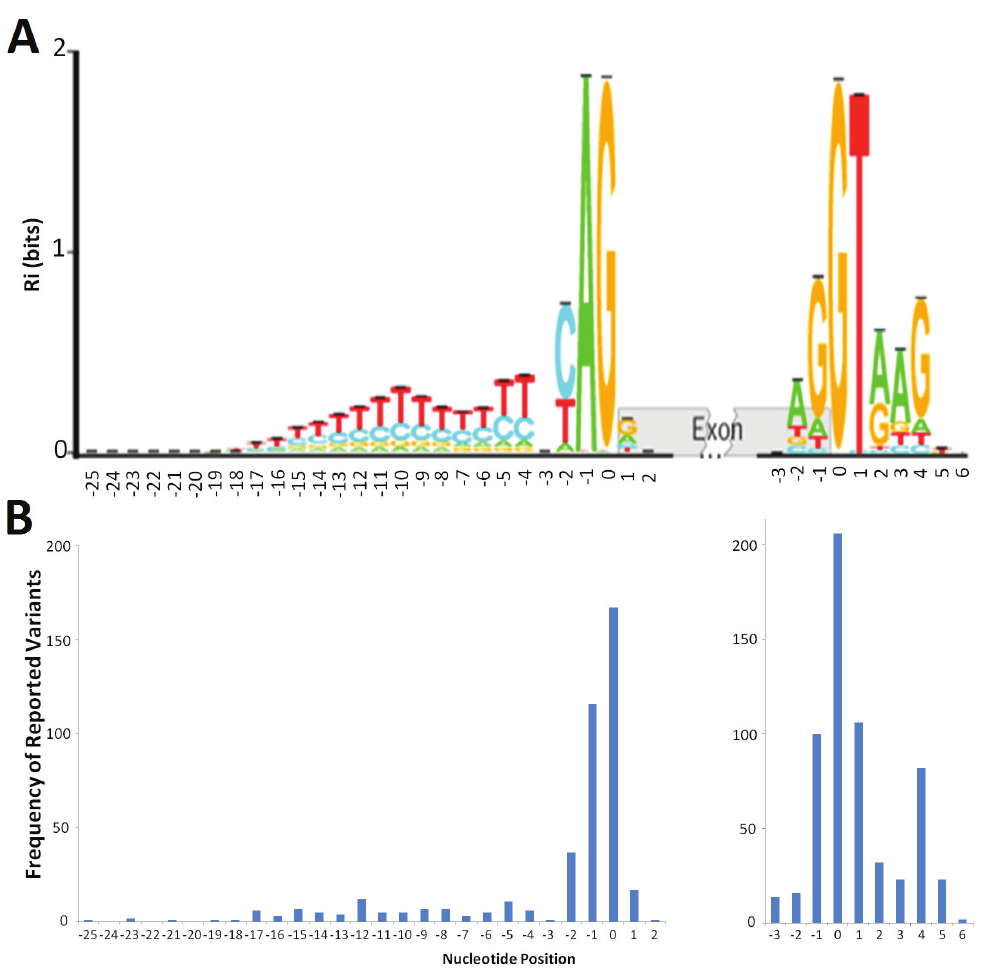
Figure 1. Distribution of deleterious natural site variants relative to information content. A ) The sequence logo for human acceptor and donor splice sites based on the positive (+) strand of the October 2000 (hg5) genome draft. The logo shows the distribution of information contents ( R in bits) at each position over the region of 28 nucleotides for acceptor [-25, +2] and 10 nucleotides for donor [-3, +6] from the i first nucleotide of the splice junction (position 0). Nucleotide height represents its frequency at that position. The horizontal bar atop each stack indicates the standard deviation at that position. This figure was modified from Rogan et al . (2003) to include splice sites in genes on both strands of the annotated human reference genome 33 . B ) The distribution of deleterious single-nucleotide variants reported at the natural acceptor (left) and donor (right) splice sites. The variants used to populate this graph (Supplementary Table 4) were included only if they were reported to negatively affect splicing (N = 431 for acceptors, 604 for donors). The image was aligned to the sequence logo ( A ) to illustrate potential correlation of number of splicing variants at a position to the information content at that